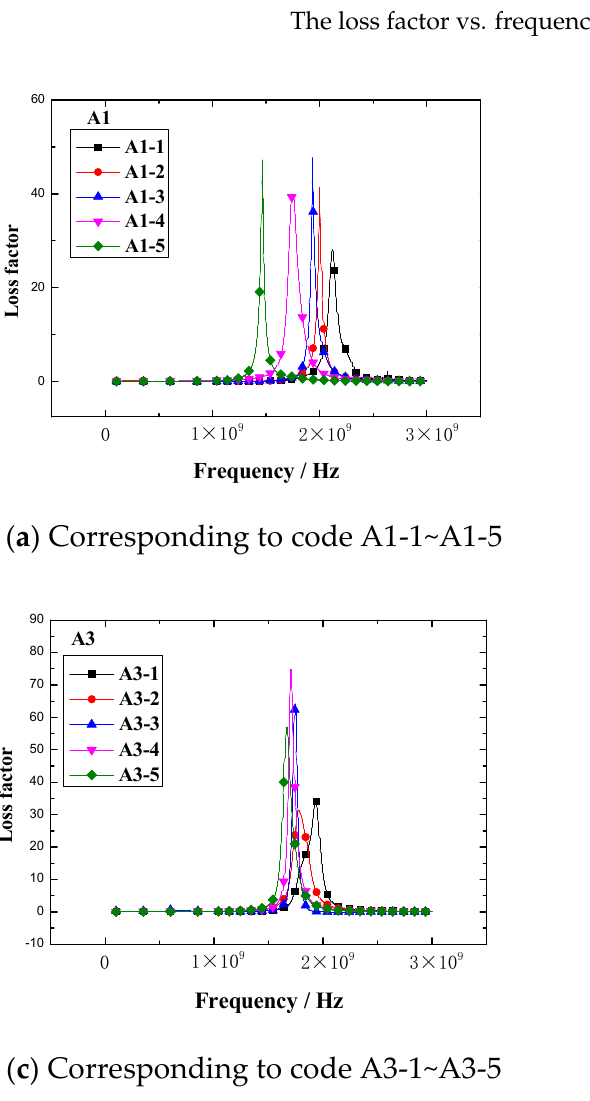
Figure 10. The peak and peak frequency of the dielectric constant of the rubber samples.